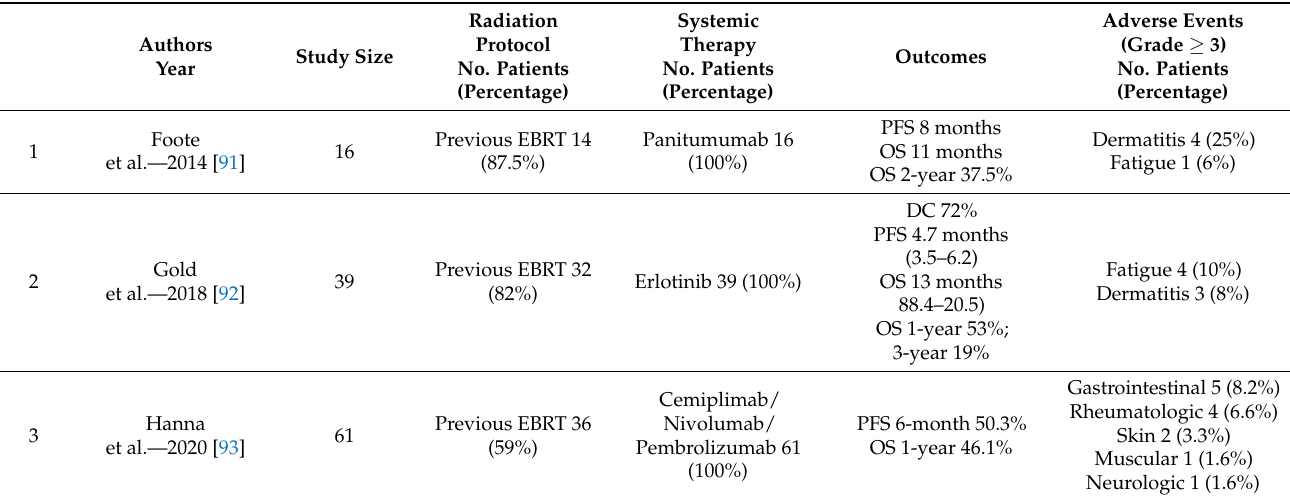
Table 3. Overview of studies including patients with metastatic cutaneous squamous cell